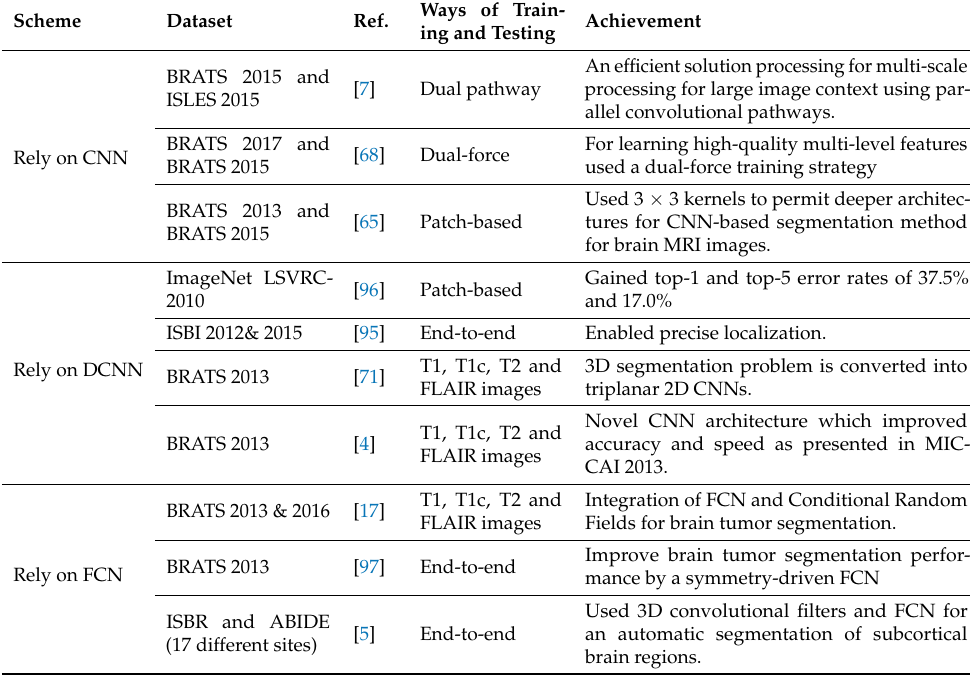
Table 4. Comparison of CNN